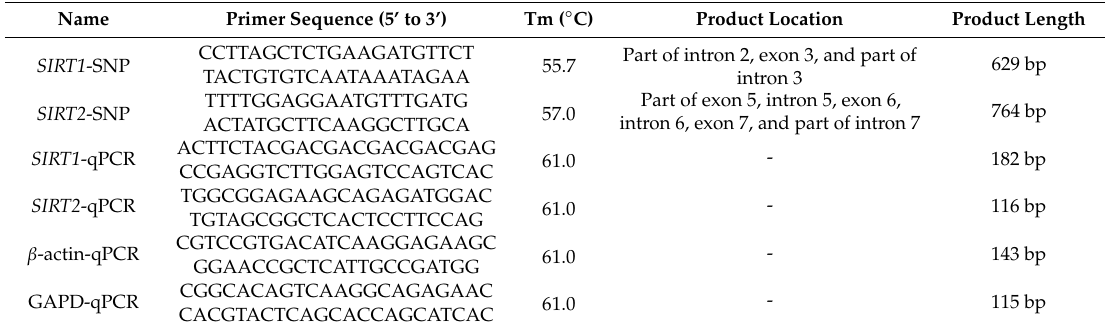
Table 1. Primers used in these